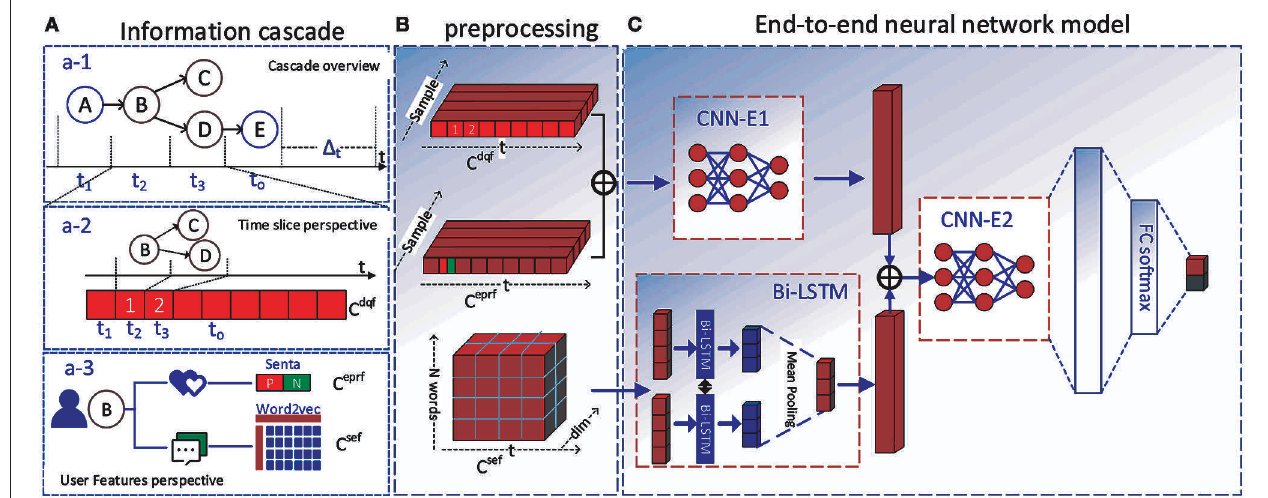
FIGURE 1 | The overall architecture of CasWarn. (A) : Three perspectives of information cascade. (a-1): The overall information cascade after time slice; (a-2): the composition form of dissemination scale feature after time slice; (a-3): features in the user’s view, including emotional polarity ratio and semantic evolution features. (B) : Different feature preprocessing and embedding representation processes. (C) : The end-to-end neural network model. It first fuses the quantitative and emotional features through the CNN-E1 layer and then embeds the temporal semantic evolution features through the Bi-LSTM model, it next uses the CNN-E2 model to fuse the three features again. Finally, the FC-softmax layer predicts the